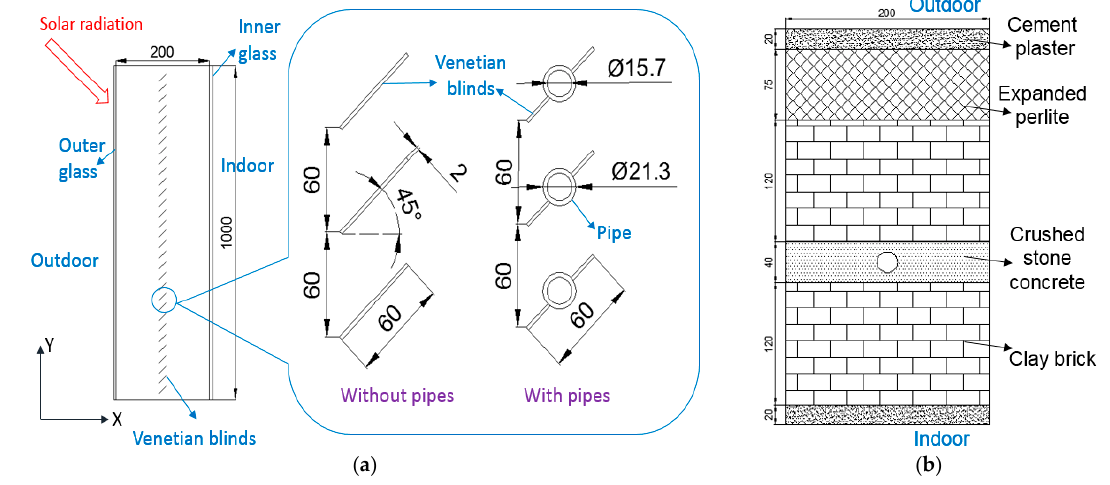
Figure 3. Structures and dimensions of the simulated envelope: ( a ) Pipe-embedded window; and ( b ) Pipe-embedded wall. Table 1. Physical parameters of the window materials.